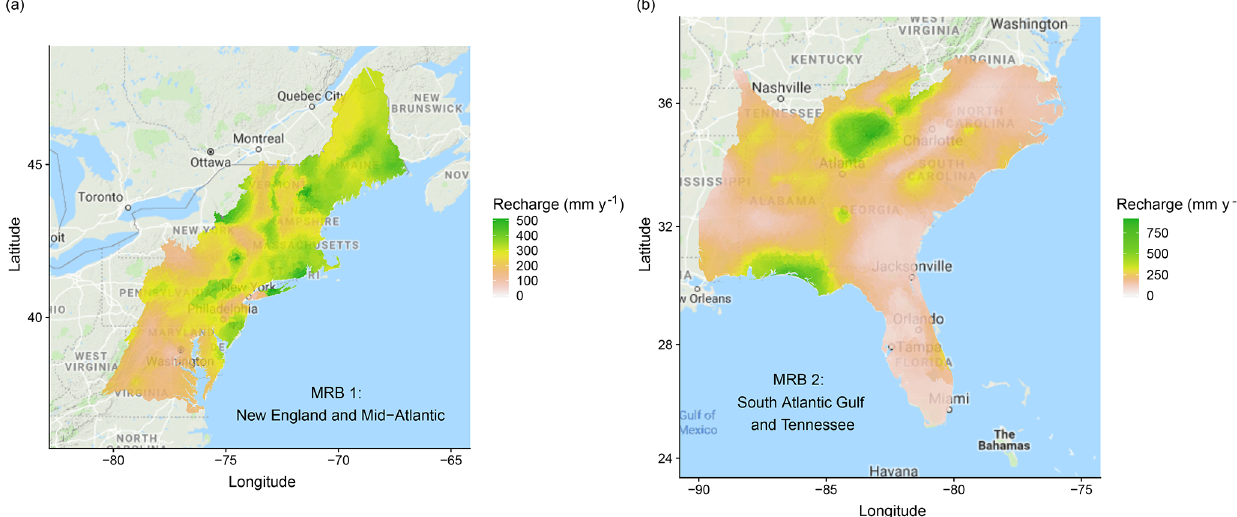
Figure 3. The study area includes (a) MRB 1 and (b) MRB 2 in the eastern US, colored by the estimated annual groundwater recharge in the year of 2002 (Wolock, 2003). For the details of the delineation of MRBs, please refer to United States Geological Survey